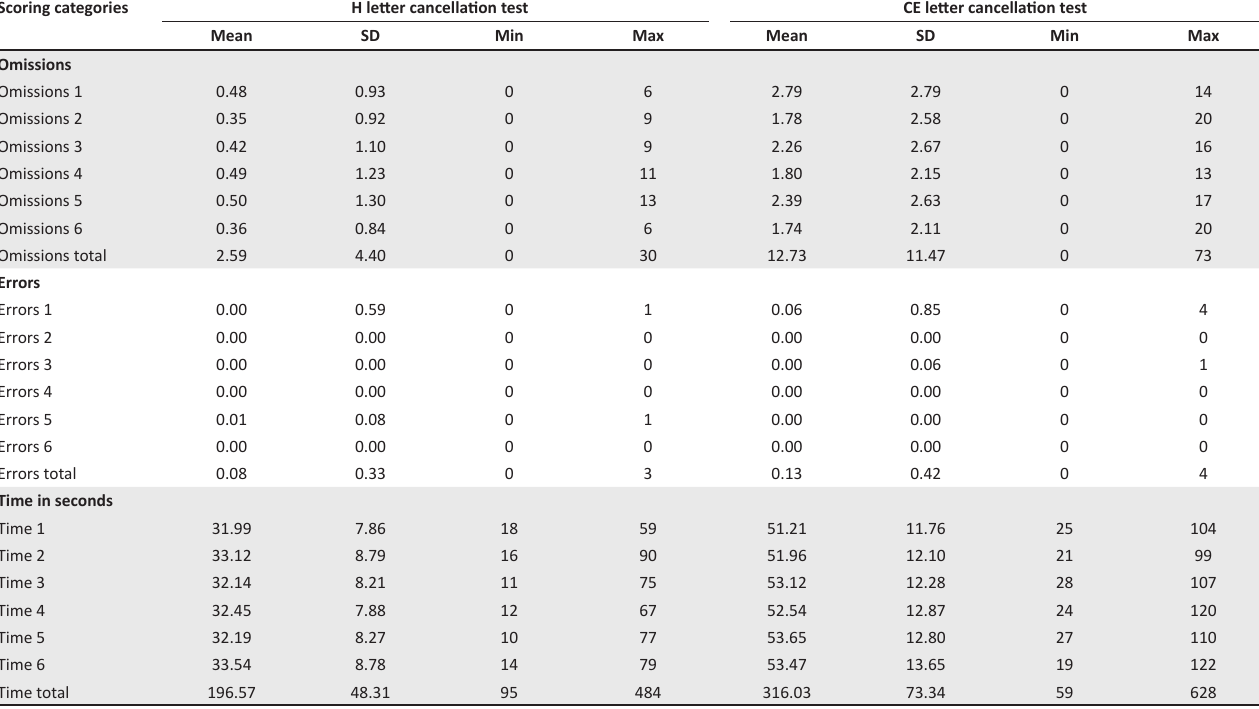
TABLE 2: Descriptive statistics for the H and the CE letter cancellation tests ( n = 292). Scoring categories